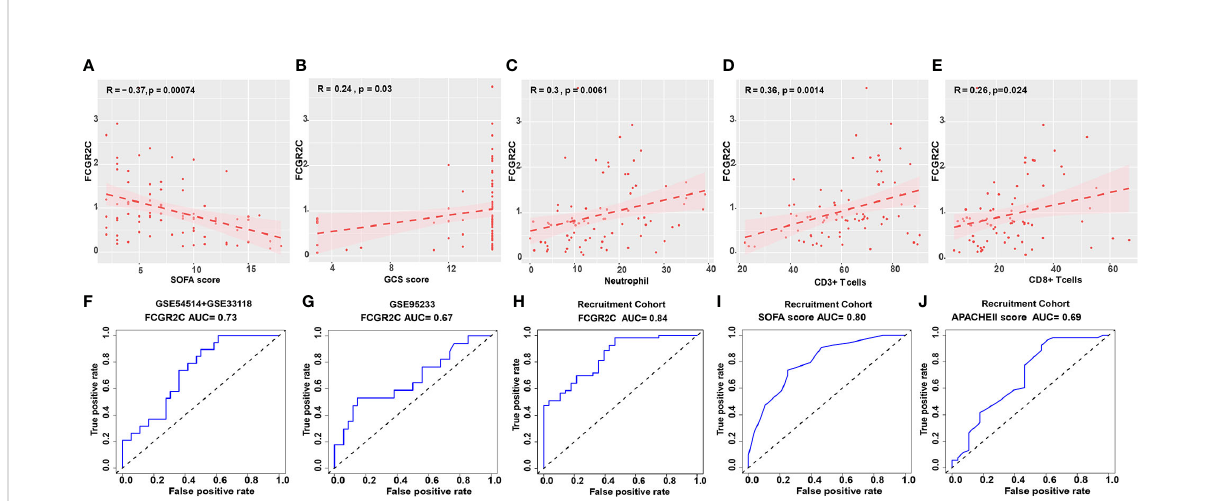
FIGURE 4 Clinical role of FCGR2C. Correlation analysis of FCGR2C with the SOFA score (A) , the GCS score (B) , neutrophils (C) , CD3+ T cells (D) , and CD8+ T cells (E) . (C-E) : The x-axis represents the absolute value of neutrophils, the percentage of CD3+ T cells, and CD8+ T cells, respectively. (F) The prognostic evaluation ability of FCGR2C in the discovery dataset (GSE54514+GSE33118). (G) The prognostic evaluation ability of FCGR2C in the fi rst validation dataset (GSE95233). The prognostic evaluation ability of FCGR2C (H) , the SOFA score (I) , and the APACHE II score (J) in the second validation cohort (our recruitment